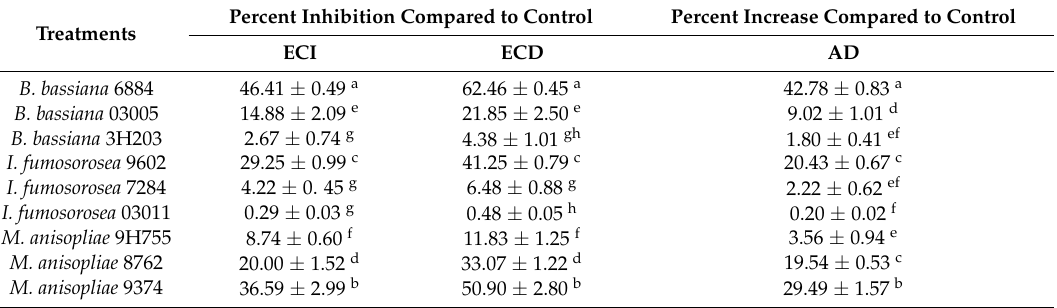
Table 3. Percent increase/decrease in nutritional indices of red palm weevils against different isolates of entomopathogenic